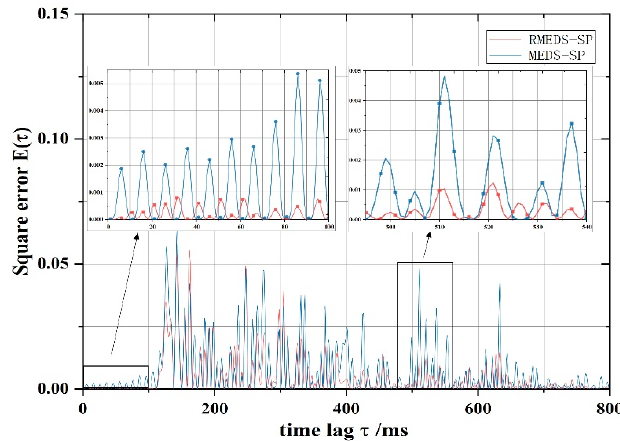
Figure 10. ACF error of MEDS-SP and RMEDS-SP.